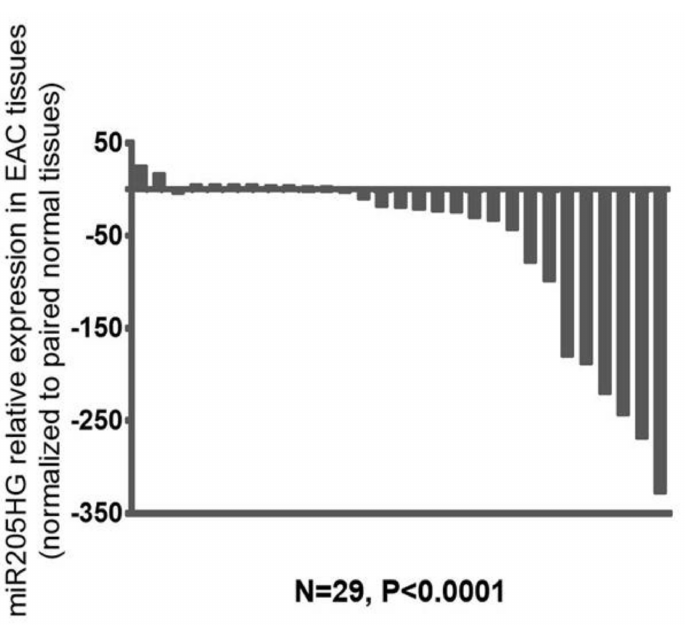
Figure 4. miR205HG expression in NE-EAC tissue pairs. Twenty-nine matched NE-EAC tissue pairs were assessed for miR205HG expression by qRT-PCR. miR205HG expression was downregulated relative to NE in the majority of EACs studied (26/29, average fold-change 68.6, paired t -test p -value < 0.0001).